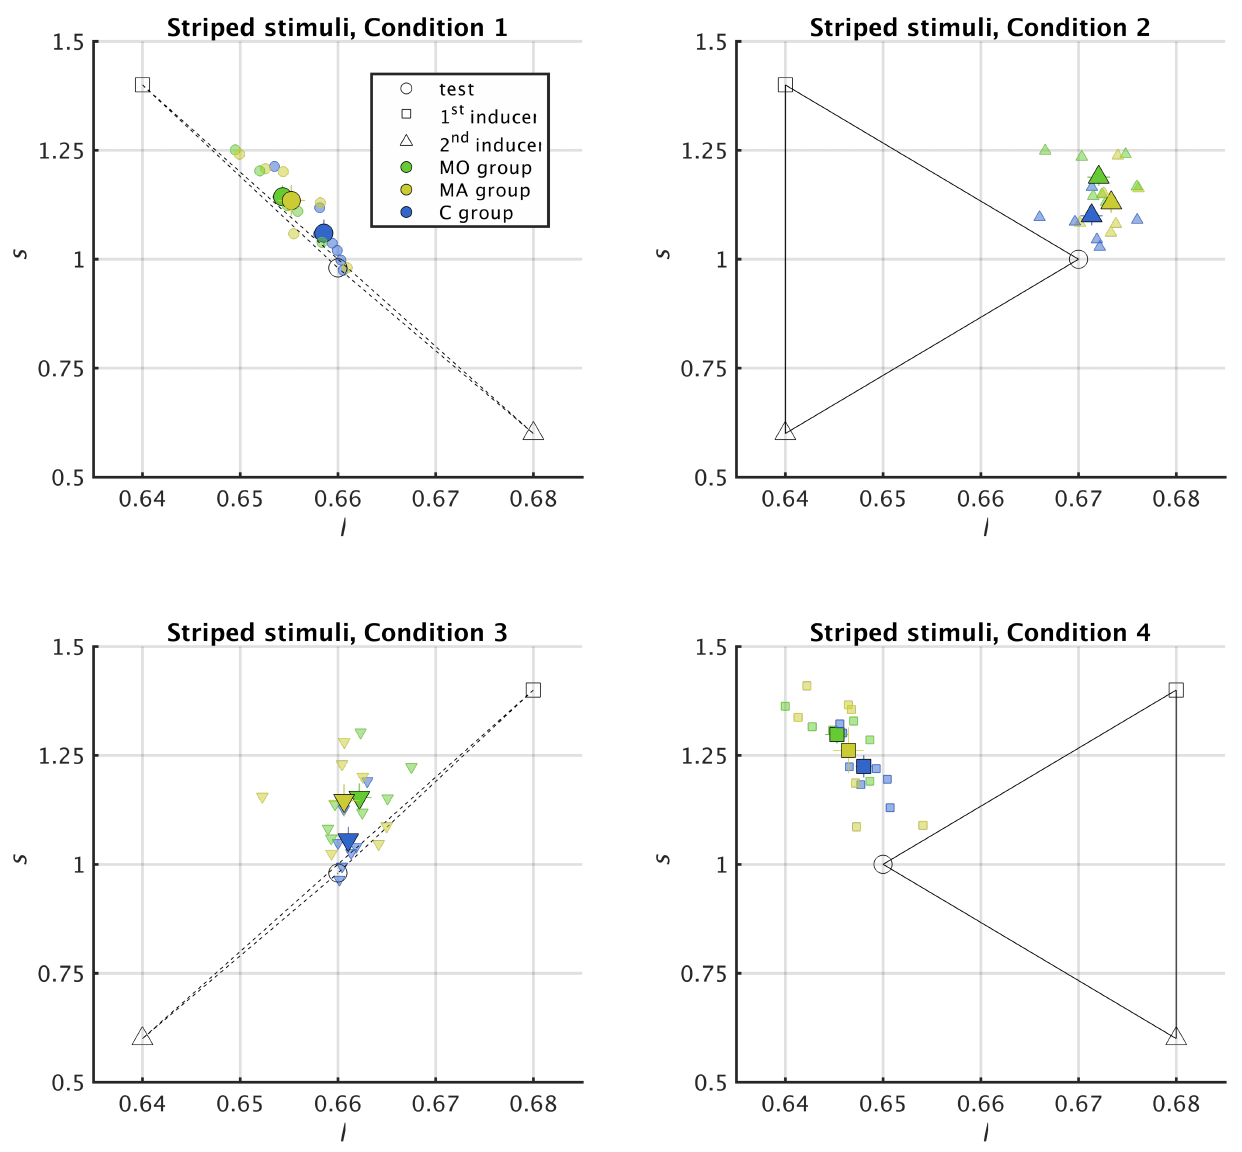
Figure 3. Experimental results for striped surrounds (Conditions 1–4 of Table 1) and 17 stripes represented in the MacLeod– Boynton chromatic space ( l , s ) . The filled symbols of different colours indicate the perceived colours (the chosen values for the comparison ring) for the different groups (migraine without aura, MO, migraine with aura, MA and control, C). The small symbols represent the individual data and the big ones represent the group means. The error bars indicate the standard error of the mean. The open symbols show the colour of the first (squares) and second (triangles) inducers, and of the test ring